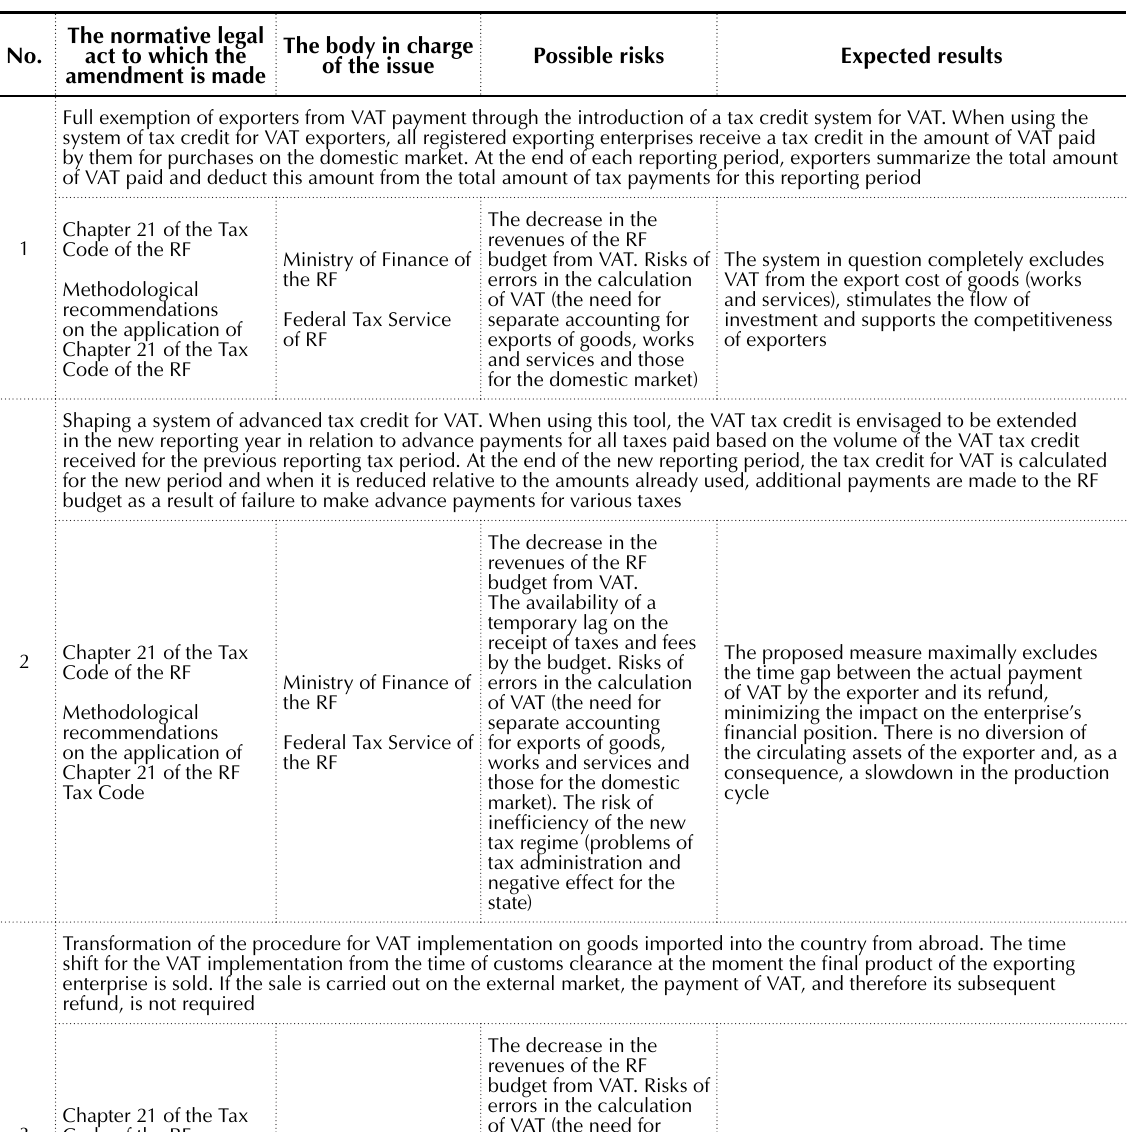
Source: Compiled by the